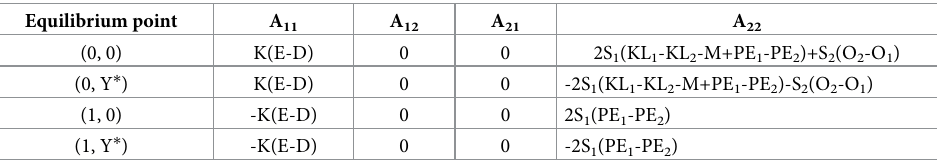
Table 2. The specific values of A 11 , A 12, A 21 and A 22 at the local equilibrium point. Equilibrium